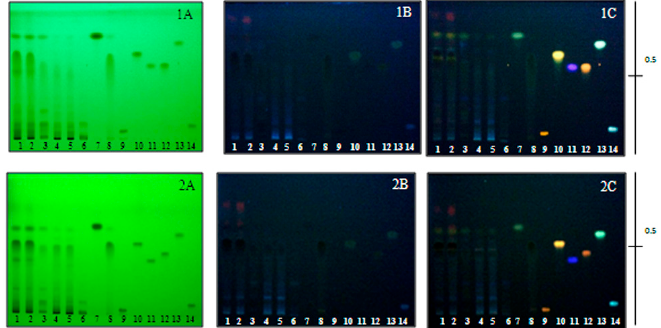
Figure 1. TLC chromatogram of O. indicum extracts; 1 = OPCE, 2 = OPCD, 3 = OPNE, 4 = OPND, 5 = OSBE, 6 = OSBD, 7 = biochanin A, 8 = baicalein, 9 = rutin, 10 = quercetin, 11 = gallic acid, 12 = myricetin, 13 = kampferol, 14 = chlorogenic acid. Adsorbent: Silica gel GF254. Solvent system: 1 =ethyl acetate-glacial